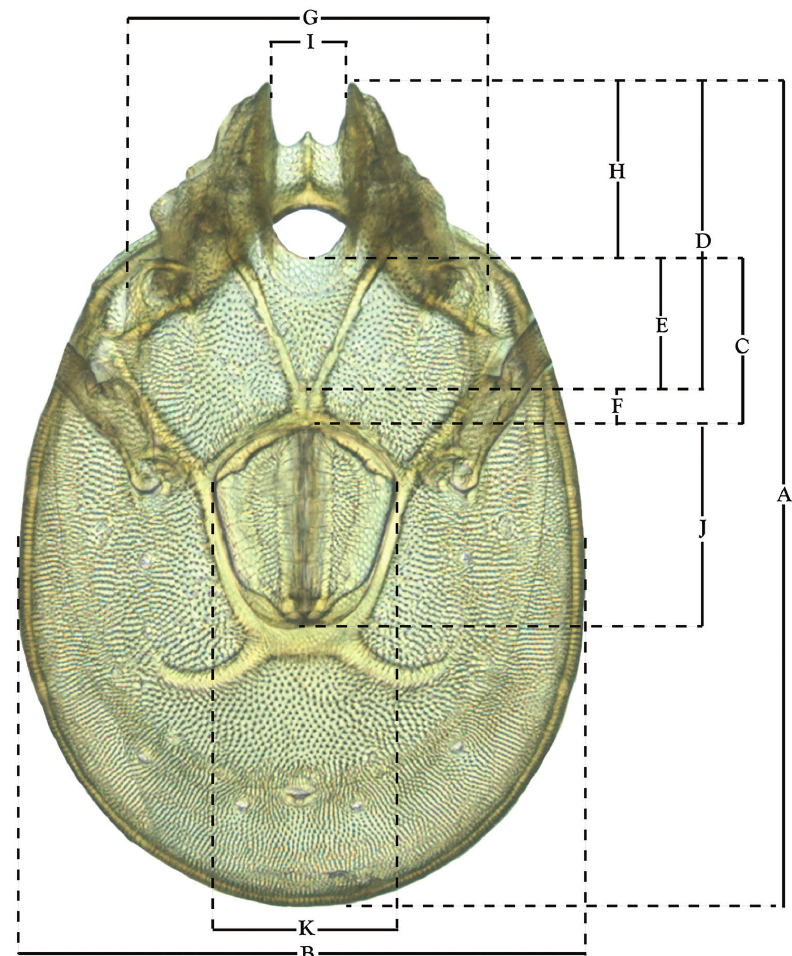
Figure 6. Venter measurements: A ventral length B ventral width C anterior venter D coxa-I total length E coxa-I medial length F medial suture length G coxa-III width H gnathosomal bay length I gnathosomal bay width J genital field length K genital field width. T. multiforma Habeeb, 1974